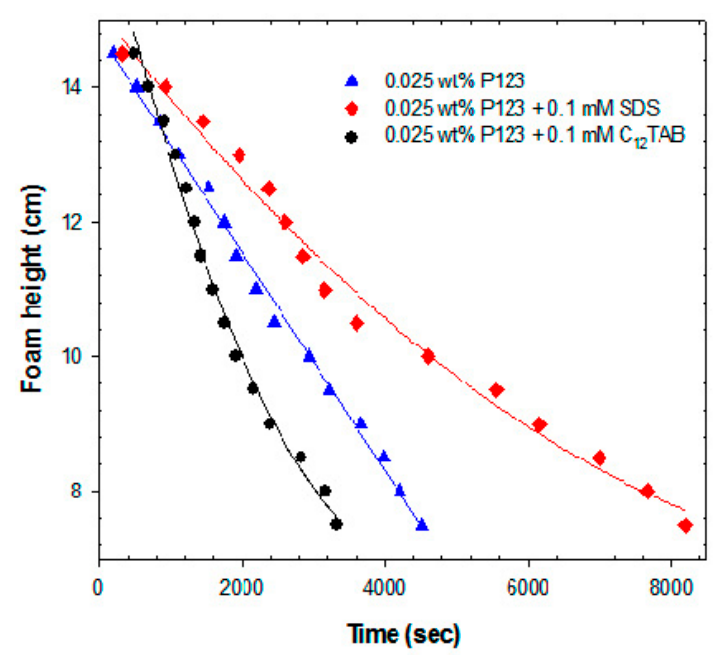
Figure 2. Foam height of Pluronic P123 and SMS mixtures as a function of time.